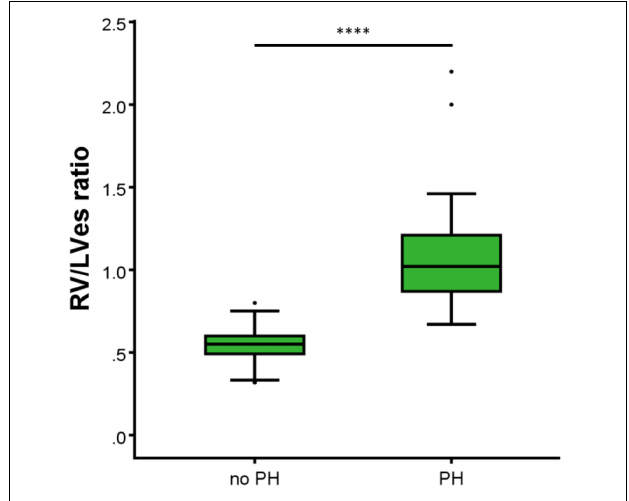
FIGURE 4 | Differences between the healthy study group (no PH) and pulmonary hypertension (PH) study group in RV/LVes ratio (right ventricular to left ventricular endsystolic ratio). The box plot graphs show the median, IQR and range (Tukey method 1.5 ∗ IQR). ∗∗∗∗ p < 0.0001.